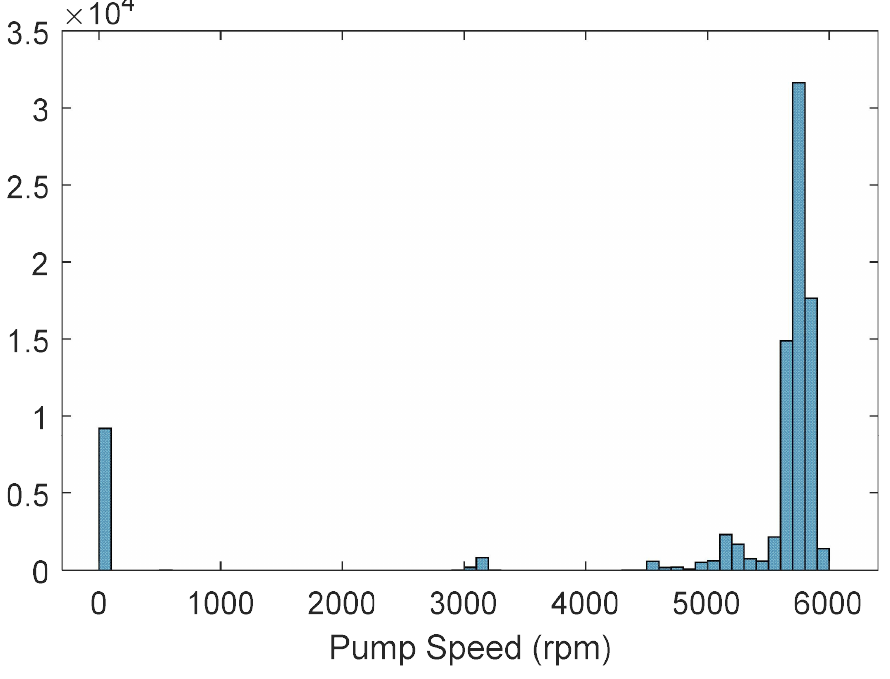
Figure 3. Pump speeds recorded over the course of a year of operation taken at 8 h intervals. Several modes are evidently indicating the different operating regimes the pump is subjected to.